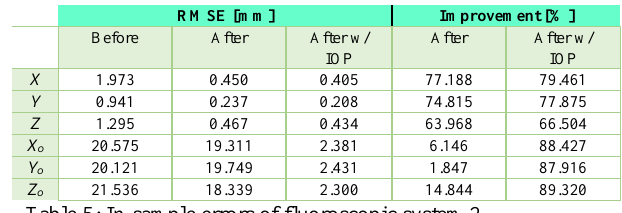
Table 5: In-sample errors of fluoroscopic system 2